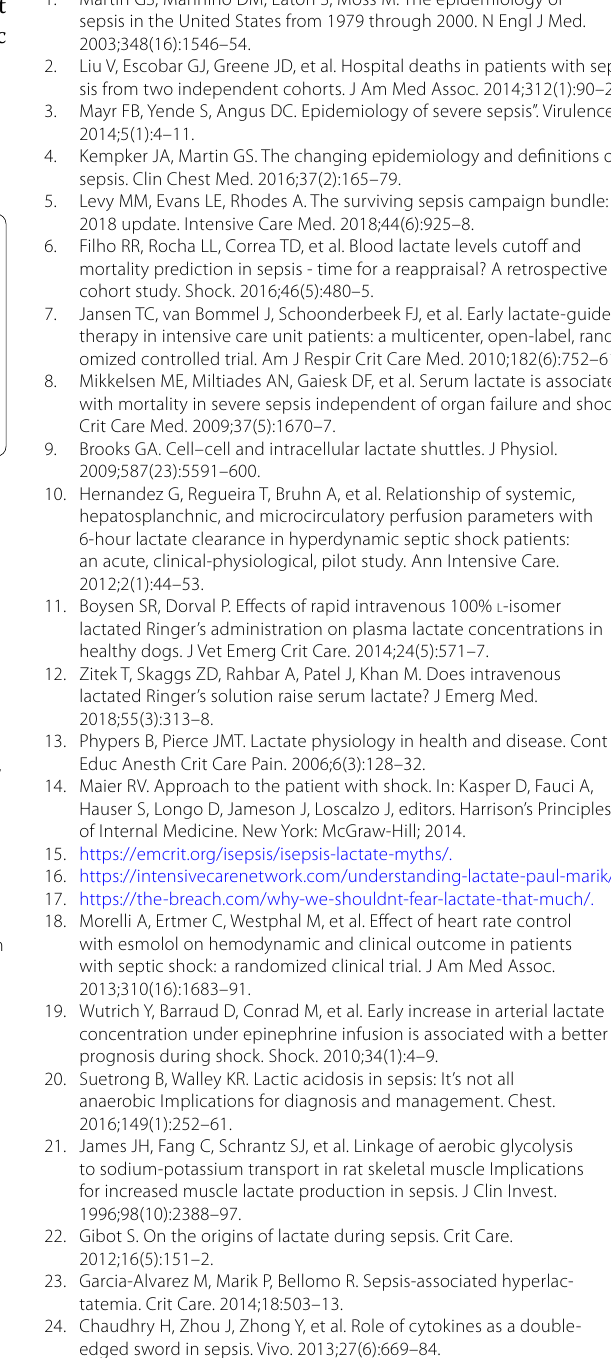
Additional file 3: Figure S1. Estimated hazard ratio for ICU discharge at specific HR for every 10 mm Hg higher MAP (shows MAP-by-HR interac- tion). Error bars represent 95% confidence